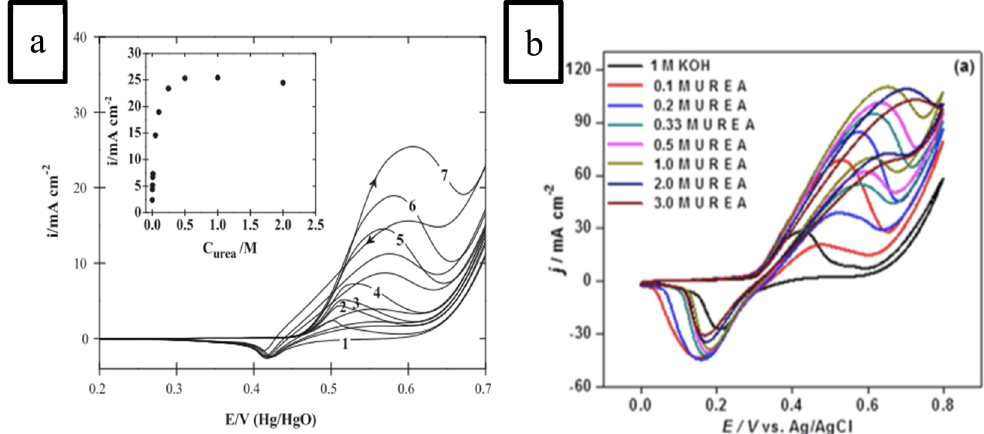
Figure 5: The dependence of urea electro - oxidation on urea concentrations at ( a ) nickel nanoparticle and ( b ) NiCo/MWCNT electrode. Scan rates at ( a ) was 10 mV s − 1 , while at ( b ) was 20 mV s − 1 , republished with permission [ 1,47 ]